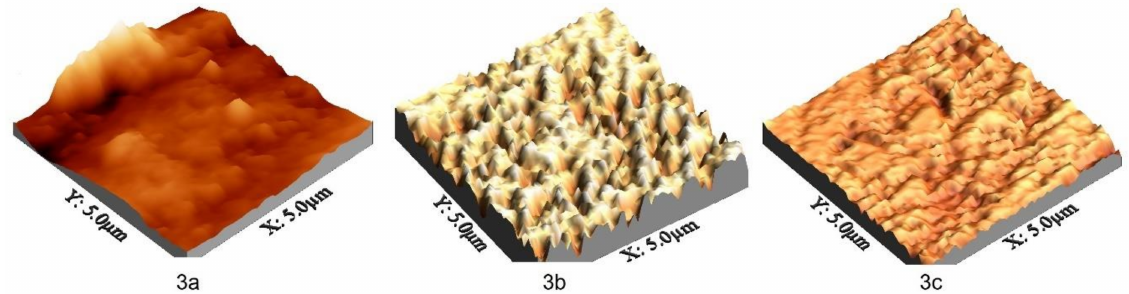
Figure 4. AFM images of the aminocarbenes films ( 3a = 2-pyridyl; 3b = 3-pyridyl; 3c = 4-pyridyl